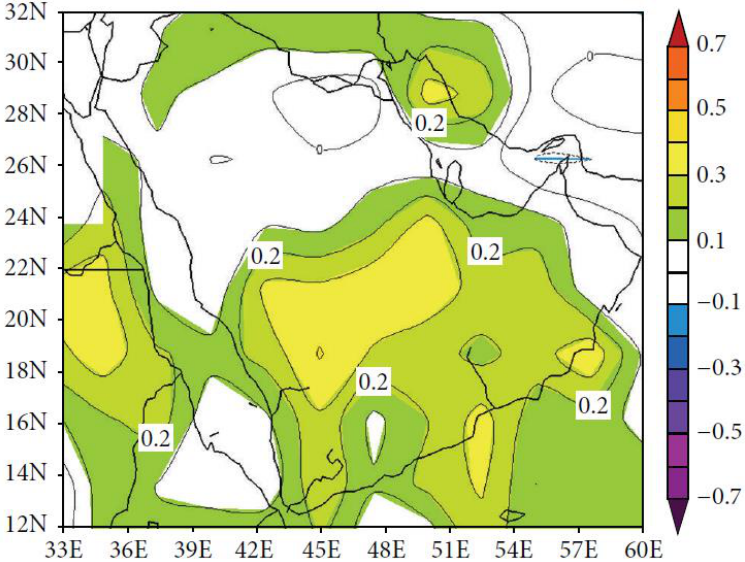
Figure 28. The distribution of the linear correlation coefficient between surface CMAP precipitation (enhanced) over SA and NAO through the period from 1979 to 2011 in summer season